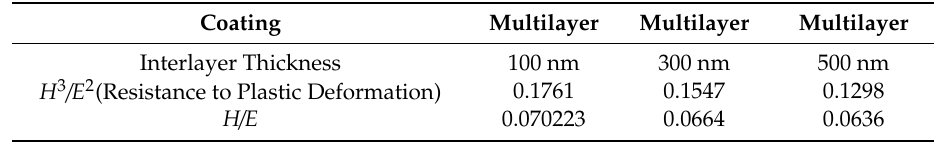
Table 4. Variation of dimensionless parameter H 3 / E 2 and H / E with the interlayer